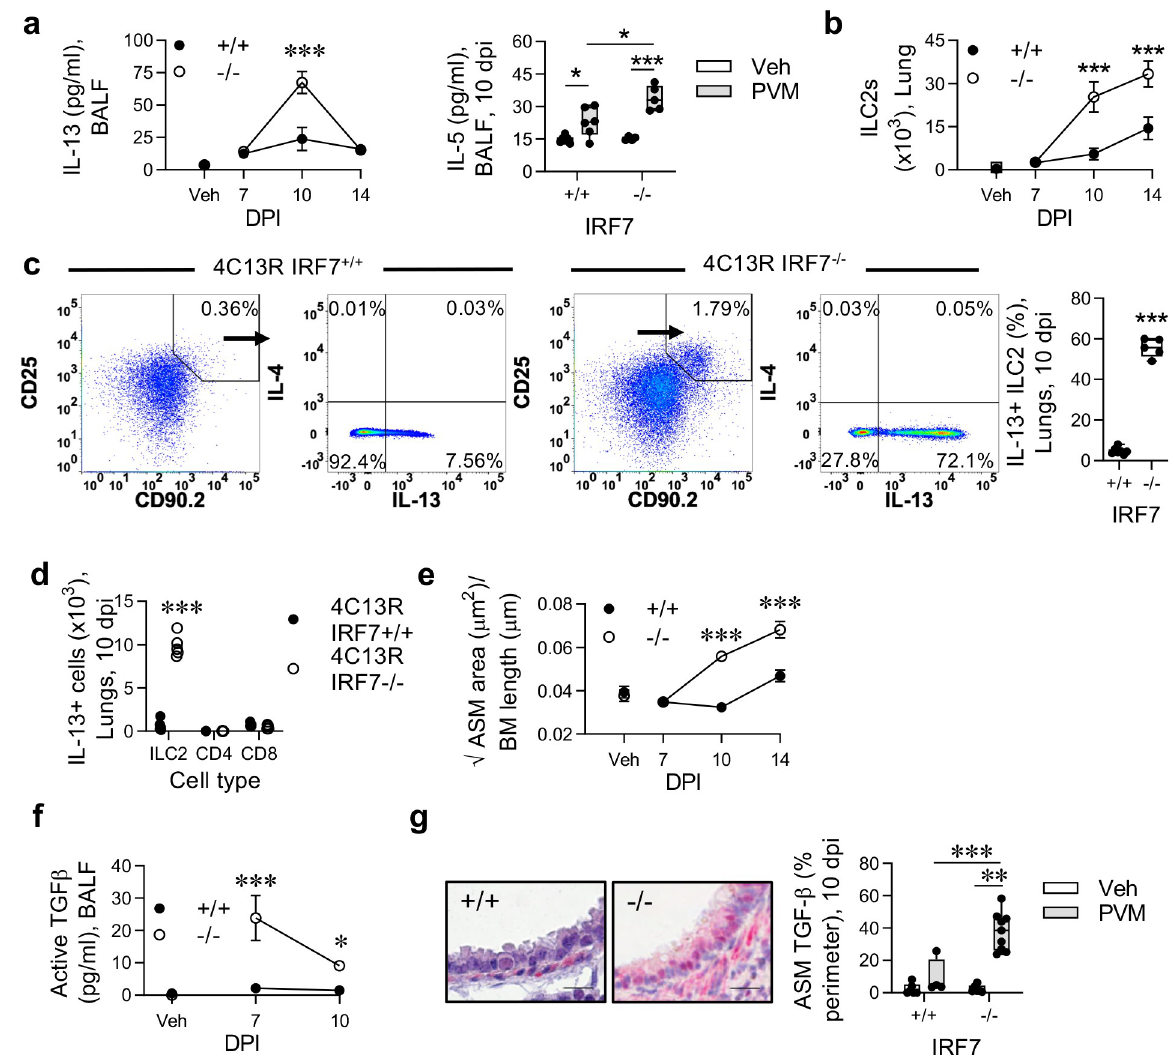
Fig 2. IRF7 deficiency predisposes to Pneumovirus-induced type-2 inflammation and ASM growth in early-life. WT (IRF7 +/+ ) and IRF7 -/- mice were inoculated with PVM at postnatal day 7 and endpoints assessed at the times indicated. (a) IL-13 and IL-5 protein (10 dpi) expression in BALF. (b) ILC2 numbers in the lung (c) Expression of IL-13 (dsRed) and IL-4 (AmCyan) by ILC2 in the lungs of 4C13R IRF7 +/+ and 4C13R IRF7 -/- mice at 10 dpi. Numbers in quadrants show the percentages of gated cells. Percentage of IL-13-expressing ILC2 (right panel). (d) Numbers of IL-13-producing ILC2, CD4 + and CD8 + cells in left lung lobe at 10 dpi. (e) ASM area. (f) Active TGF β protein expression in BALF. (g) Representative micrograph (x400 magnification) of TGF- β 1 immunoreactivity (red) in the lung at 10 dpi. Bars, 20 μ m (left panels). Quantification of TGF- β 1 expression by ASM cells (right panel). Data are representative of n = 2 experiments with 4 to 8 mice in each group and are presented as mean ± SEM (a [left], b, e) or as box-and-whisker plots showing quartiles (boxes) and range (whiskers; a [right], c [right], d, f). Data were analysed by Two-way ANOVA with Tukey post hoc test (a [left], b, e) or One-way ANOVA with Dunnett post hoc test (a [right], f [right[) or T-test (c [right], d); � , P < 0.05; �� , P < 0.01; ��� , P < 0.001 compared with the WT control group or as indicated.